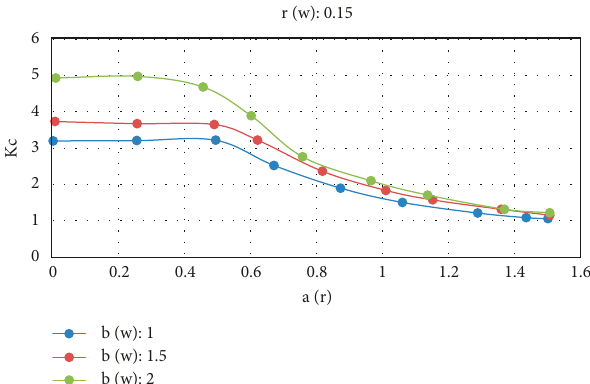
Figure 31: Dimensionless figure of tension coefficient according to crack length to radius ratios and different length to width for cavity with 0/15 ratio.